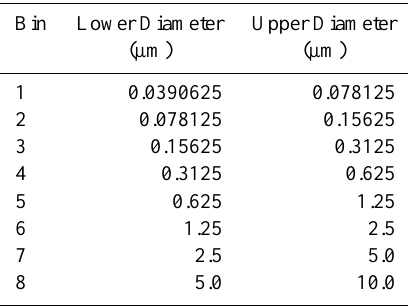
Table 2. Particle dry-diameter range for the eight MOSAIC aerosol size bins employed in this